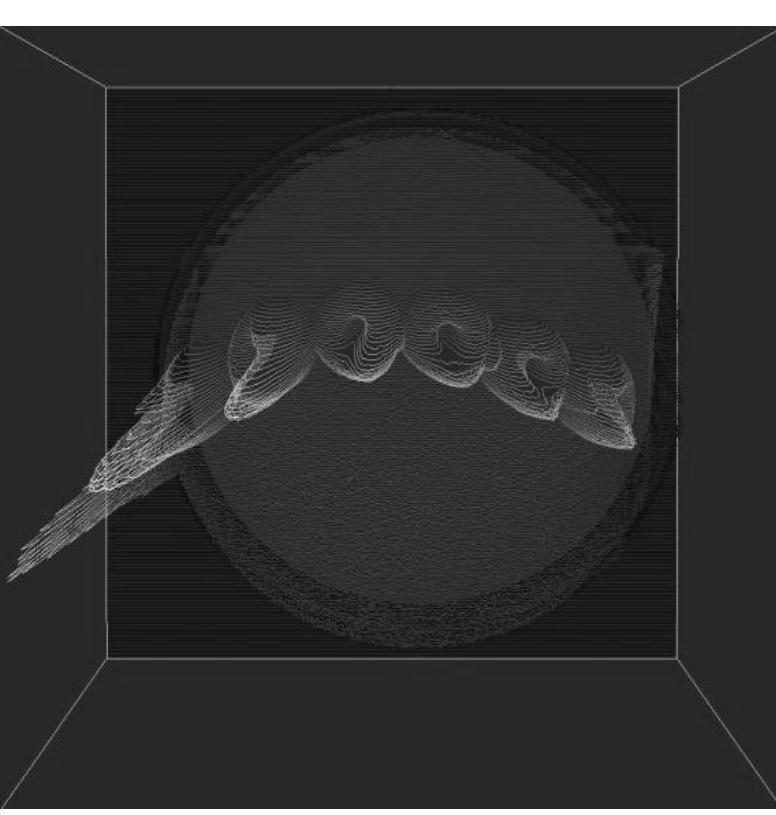
Figure 11. 3D plot of the scintillator measurement of the 6 beam spots in the Setup 2 configuration, with the lens on. The image is shown looking down along the beam